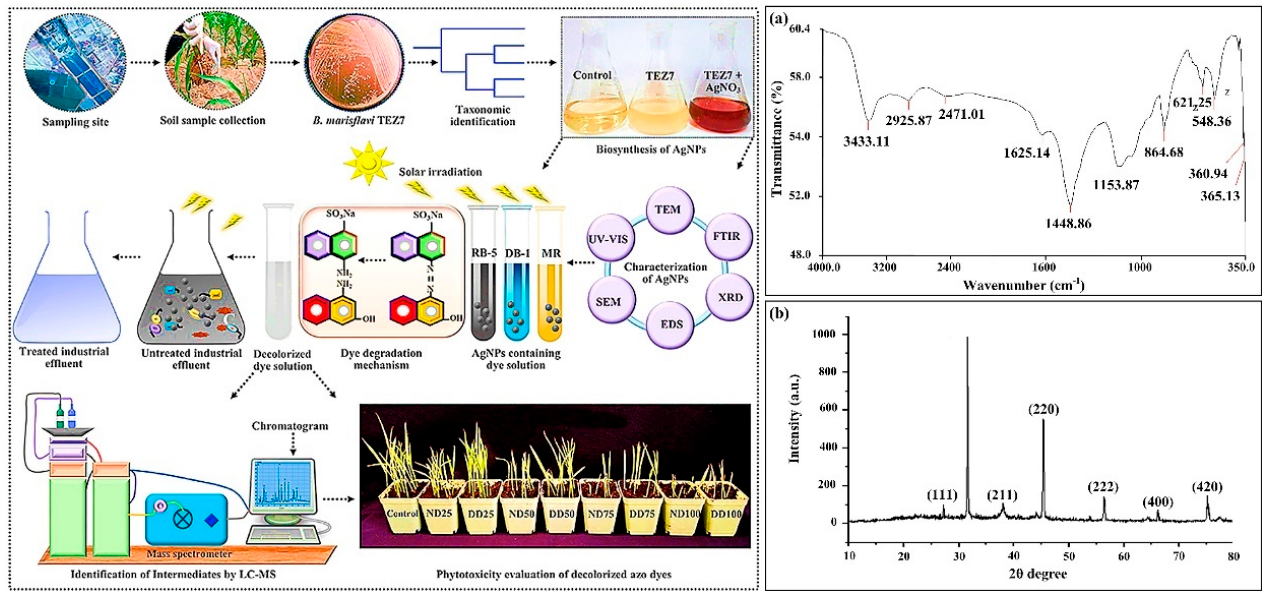
Figure 6. Silver nanoparticles transformed synthetic textile dye through LC-MS analysis and treated the actual wastewater. And Characterization of biogenic AgNPs by ( a ) FTIR spectra and ( b ) XRD analysis to measure the functional groups capping the NPs and to elucidate the crystal structure [78]. Reprinted/adapted with permission from Ref. [78]. 2022, Elsevier B. V”.